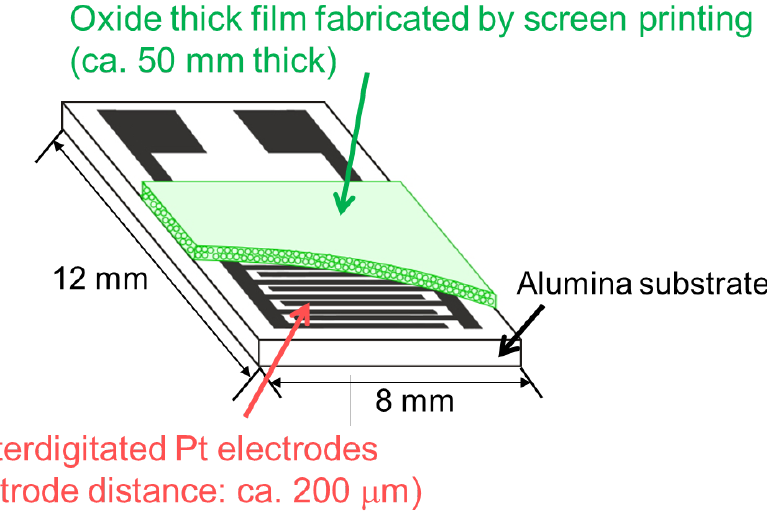
Figure 1. Schematic drawing of a sensor element.